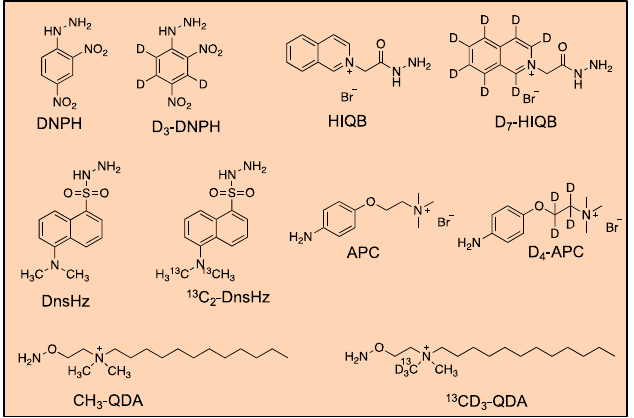
Figure 6. Commonly used differential isotope labeling reagents for profiling and relative quantitation of carbonyl compounds.